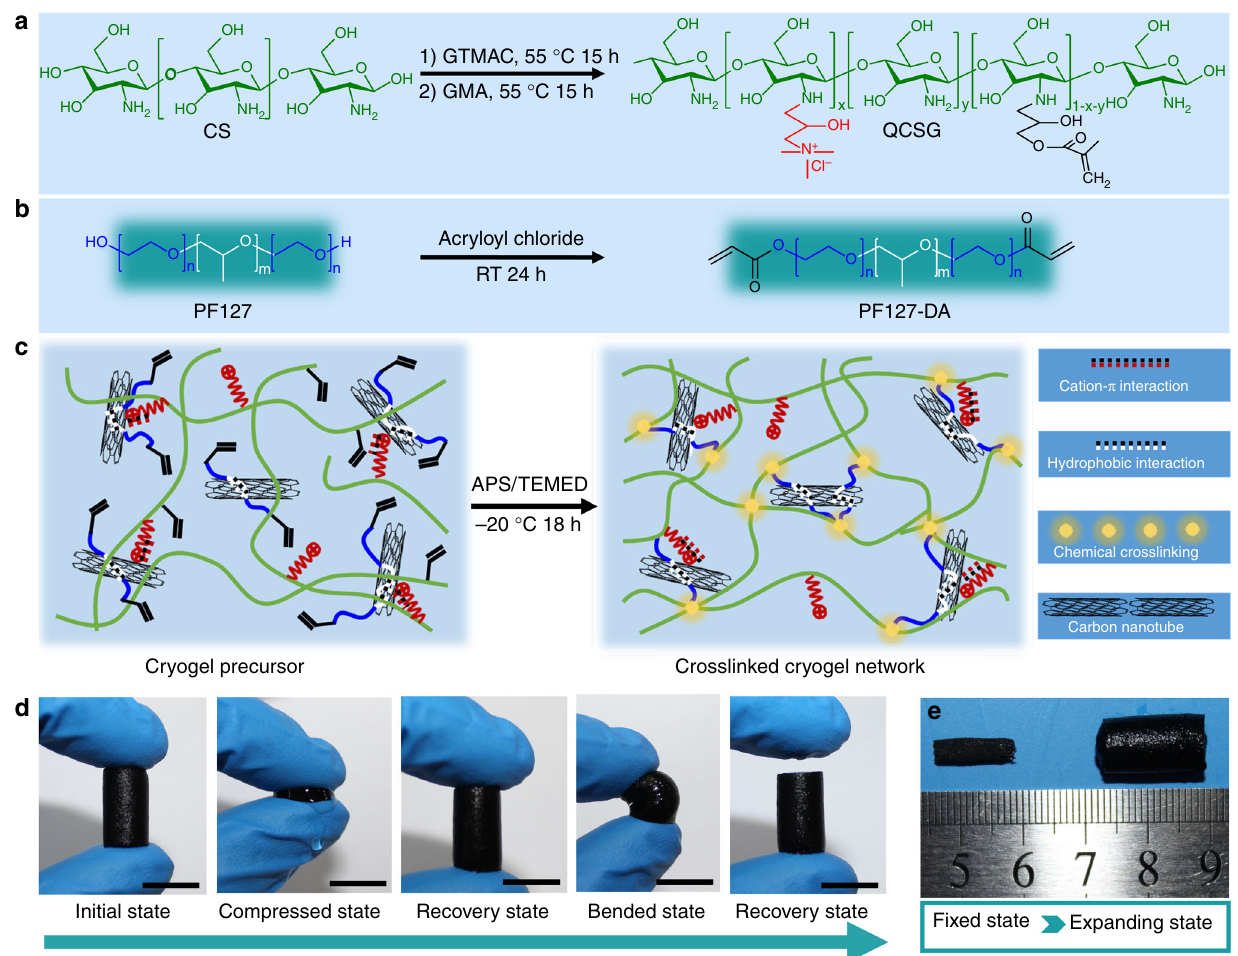
Fig. 1 Schematic representation of QCSG/CNT cryogel synthesis. a Synthesis of QCSG copolymer. GTMAC and GMA with a fi xed 0.5:1 molar ratio of GMA to amino groups and varying the GTMAC: amino groups from 1:1 (coded as QCSG1) to 2:1 (coded as QCSG2) and 3:1 (coded as QCSG3). b Synthesis of PF127-DA copolymer. c Preparation of QCSG/CNT cryogel. d Photographs of the compression and bending resistance capability of QCSG/CNT4 cryogels: initial state, compressed state by squeezing out of the free water, recovery state by absorbing water, bending and squeezing out of part free water, and recovery state after absorbing water. e Shape- fi xed state after removing the free water (left) and expanding state after absorbing water (right). Scale